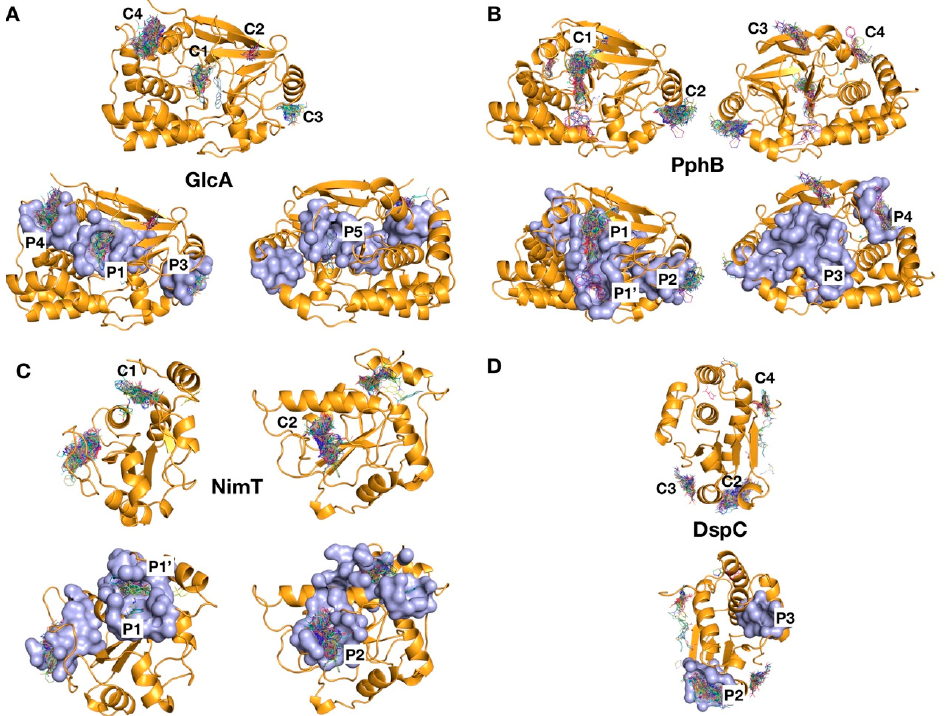
Figure 3. Virtual screening (VS) ligand clusters and druggable pockets for the AfPPases. Molecular models are shown in orange cartoons, ligands as lines, and druggable pockets in blue surface rendering. ( A ) VS results for GlcA, top: ligand clusters from VSpipe blind docking; bottom: ligand clusters and druggable pockets superimposed on the ribbon diagram; bottom left: front view, bottom right: back view. ( B ) VS results for PphB, top ligand clusters from blind docking, top left: front view, top right: back view; bottom: ligand clusters and druggable pockets superimposed on the ribbon diagram; bottom left: front view, bottom right: back view. ( C ) VS results for NimT, top: ligand clusters from VSpipe blind docking; top left: front view, top right: side view; bottom ligand clusters and druggable pockets superimposed on the ribbon diagram; bottom left: front view, bottom right: side view. ( D ) VS results for DspC, top ligand clusters from VSpipe blind docking; bottom ligand clusters and druggable pockets superimposed on the ribbon diagram.